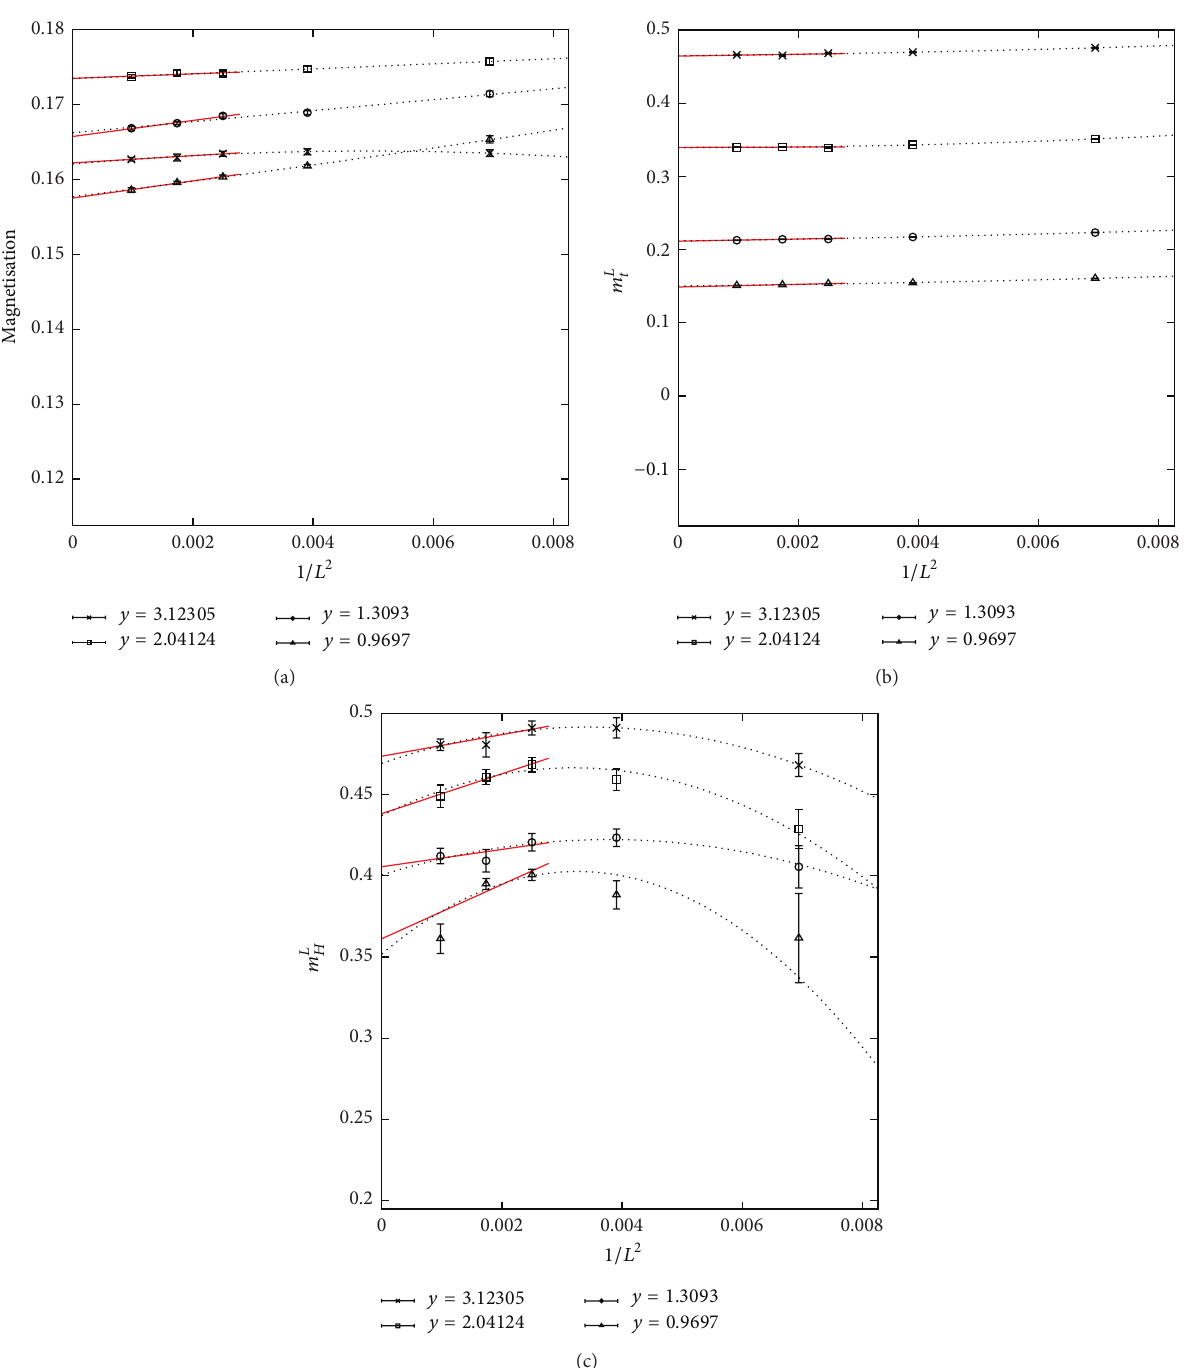
Figure 1: Finite volume effects in the magnetisation as defined in (16) and (17) (a), the fermion mass (b), and the Higgs boson mass (c) at a cutoff around 1.5TeV. The data are obtained at infinite bare scalar-quartic coupling, The lattice sizes used are 𝐿 = 𝐿 𝑠 = 12, 16,20, 24 , and 32 . We show linear (solid lines) and quadratic (dotted lines) fits in 1/𝐿 2